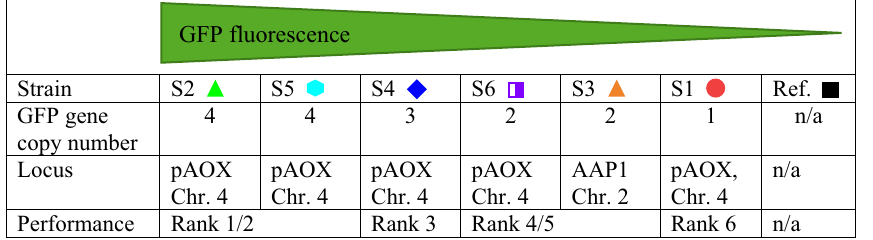
Table 1. Summary of the Whole Genome Sequencing (WGS) results for the six tested GFP-secreting P. pastoris Mut S strains and the reference strain. The table refers to Figs. 3 and 4 and summarizes the GFP gene copy number present in each tested strain and the integration locus. Strains were ranked according to the gene copy number. An identical gene copy number was evaluated with the same rank. The WGS results, including expression cassette orientation, are shown in Supplementary Fig.